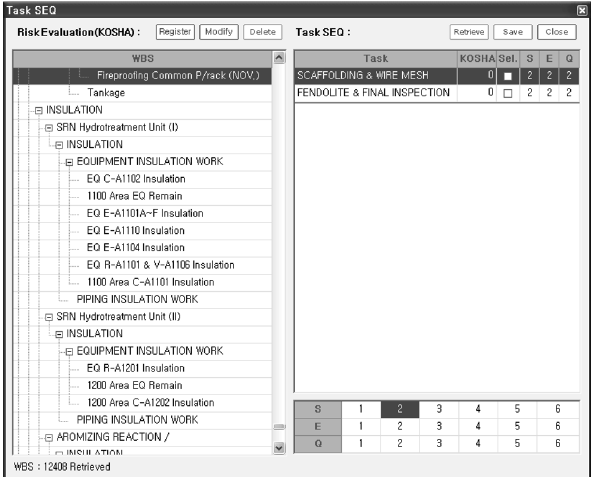
Fig. 3. Work task assessment